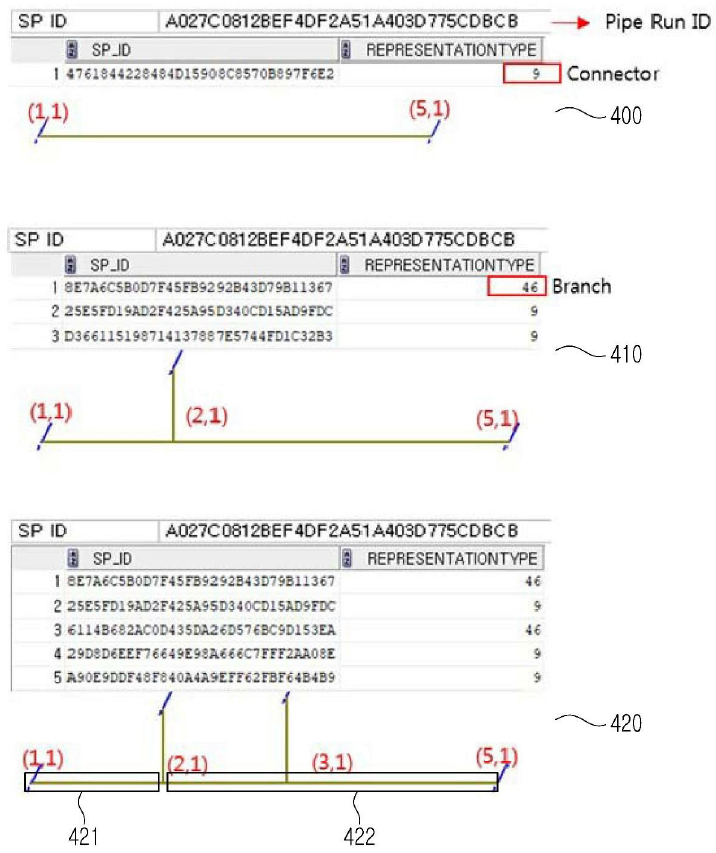
Figure 8. An example of calculating the connectors to connect branches .